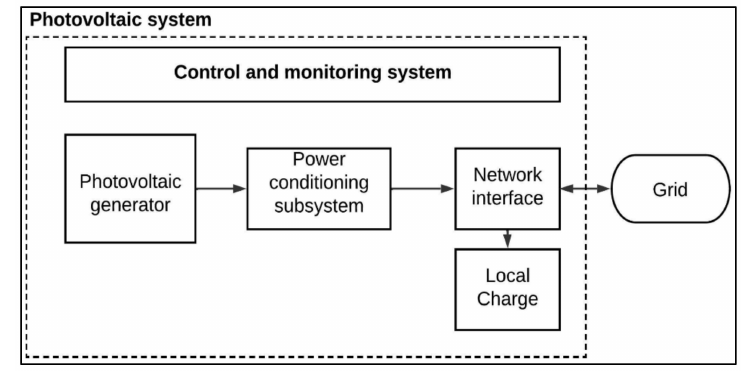
Figure 5. Block diagram of an On Grid-PV system